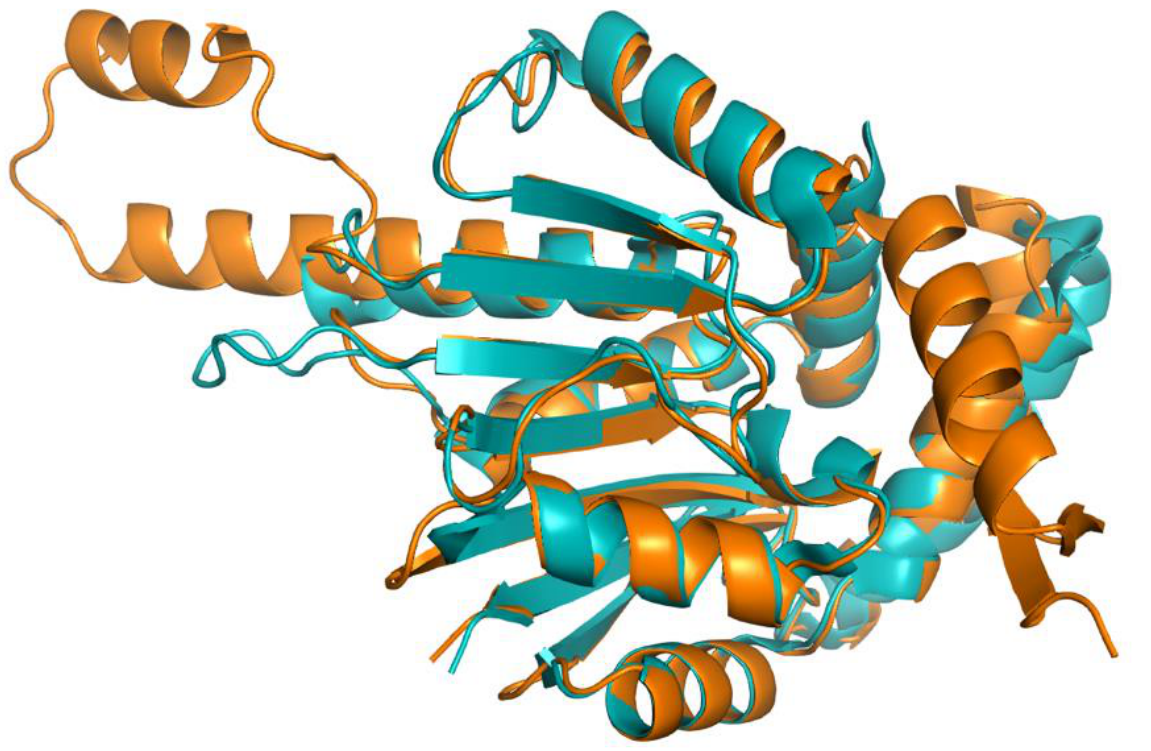
Figure A3. Structural alignment of the human COQ5 model (shown in orange) and the crystal structure of S. cerevisiae Coq5, apo form (shown in teal, PDB: 4OBX). Residues 1–47 of the AlphaFold model were omitted due to disordered structure. Alignment was performed using PyMOL.